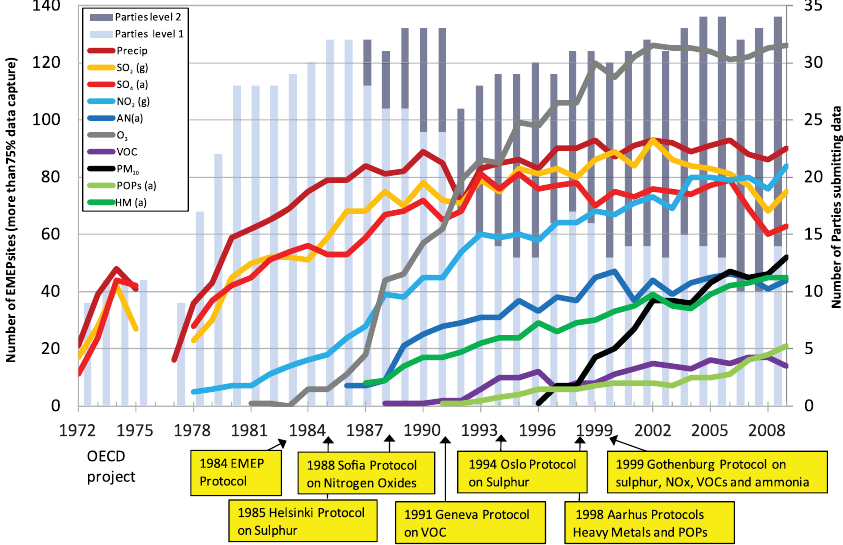
Fig. 1. Development of the measurement programme. Bars represent the number of parties/countries submitting data according to the level-1 and level-2 monitoring requirements, respectively. Lines indicate the number of sites for which measurements of the various variables have been measured (g) = gaseous, (a) = aerosol, AN = NH 3 + NH +